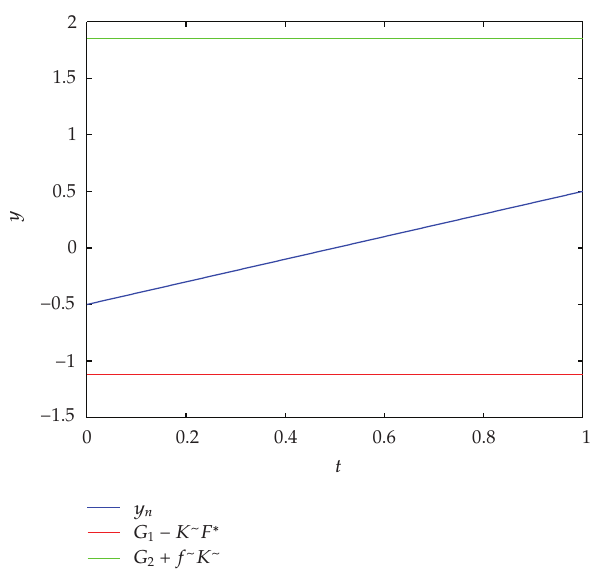
Figure 1: Numerical solution for the problem (cid:2) 1.1 (cid:3) described in Example